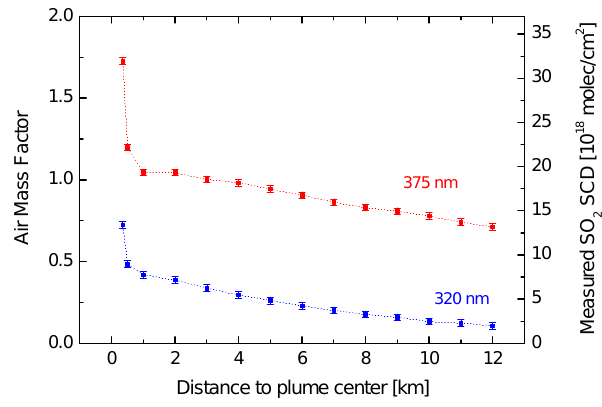
Fig. 5. Simulated air mass factors (AMF) for remote sensing mea- surements of a volcanic plume with high aerosol load performed at 320 (shown in blue) and 375nm (shown in red). The distance be- tween the volcanic plume and the remote sensing instrument was varied between 1 and